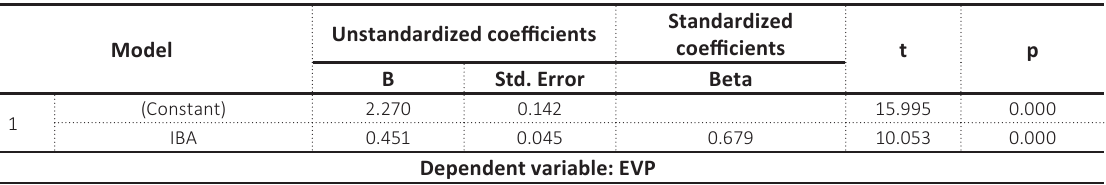
Table 6. Influence of IBA on EPV